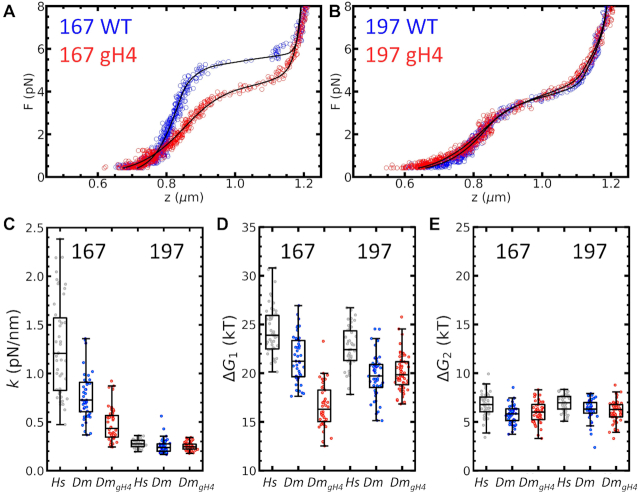
Deletion of the H4 tail affects folding in NRL 167, but not in NRL 197 chromatin fibers. (A) 167 NRL Fibers reconstituted with Dm WT histones (blue dots) unfolded similarly as those with Hs WT histones. Chromatin fibers reconstituted with Dm gH4 mutant histones (red dots) unfolded at a lower force. (B) Surprisingly, deletion of the H4 tail had no observed effect on the mechanical properties of NRL 197 fibers. Fit parameters (black lines) are given in Table S3 of the supplementary material. Irrespective of NRL, Hs WT chromatin fibers had a slightly higher \documentclass[12pt]{minimal}
\usepackage{amsmath}
\usepackage{wasysym}
\usepackage{amsfonts}
\usepackage{amssymb}
\usepackage{amsbsy}
\usepackage{upgreek}
\usepackage{mathrsfs}
\setlength{\oddsidemargin}{-69pt}
\begin{document}
}{}$k$\end{document}, \documentclass[12pt]{minimal}
\usepackage{amsmath}
\usepackage{wasysym}
\usepackage{amsfonts}
\usepackage{amssymb}
\usepackage{amsbsy}
\usepackage{upgreek}
\usepackage{mathrsfs}
\setlength{\oddsidemargin}{-69pt}
\begin{document}
}{}$\Delta {G_1},$\end{document} and \documentclass[12pt]{minimal}
\usepackage{amsmath}
\usepackage{wasysym}
\usepackage{amsfonts}
\usepackage{amssymb}
\usepackage{amsbsy}
\usepackage{upgreek}
\usepackage{mathrsfs}
\setlength{\oddsidemargin}{-69pt}
\begin{document}
}{}$\Delta {G_2}$\end{document} than Dm WT fibers. (C) In NRL 167 fibers, Dm gH4 reduced the fiber stiffness \documentclass[12pt]{minimal}
\usepackage{amsmath}
\usepackage{wasysym}
\usepackage{amsfonts}
\usepackage{amssymb}
\usepackage{amsbsy}
\usepackage{upgreek}
\usepackage{mathrsfs}
\setlength{\oddsidemargin}{-69pt}
\begin{document}
}{}$k$\end{document} significantly compared to WT histones (P < 0.001), while NRL 197 fibers were unaffected (P = 0.98). (D) Unstacking energy \documentclass[12pt]{minimal}
\usepackage{amsmath}
\usepackage{wasysym}
\usepackage{amsfonts}
\usepackage{amssymb}
\usepackage{amsbsy}
\usepackage{upgreek}
\usepackage{mathrsfs}
\setlength{\oddsidemargin}{-69pt}
\begin{document}
}{}$\Delta {G_1}$\end{document} showed the same trend: Hs WT histones featured a slightly higher \documentclass[12pt]{minimal}
\usepackage{amsmath}
\usepackage{wasysym}
\usepackage{amsfonts}
\usepackage{amssymb}
\usepackage{amsbsy}
\usepackage{upgreek}
\usepackage{mathrsfs}
\setlength{\oddsidemargin}{-69pt}
\begin{document}
}{}$\Delta {G_1}$\end{document} than Dm WT histones, both for NRL 167 and NRL 197. Deletion of the H4 tail reduced \documentclass[12pt]{minimal}
\usepackage{amsmath}
\usepackage{wasysym}
\usepackage{amsfonts}
\usepackage{amssymb}
\usepackage{amsbsy}
\usepackage{upgreek}
\usepackage{mathrsfs}
\setlength{\oddsidemargin}{-69pt}
\begin{document}
}{}$\Delta {G_1}$\end{document} for NRL 167 (P < 0.001). For NRL 197 the unstacking energy was not different (P < 0.35). The much lower \documentclass[12pt]{minimal}
\usepackage{amsmath}
\usepackage{wasysym}
\usepackage{amsfonts}
\usepackage{amssymb}
\usepackage{amsbsy}
\usepackage{upgreek}
\usepackage{mathrsfs}
\setlength{\oddsidemargin}{-69pt}
\begin{document}
}{}$\Delta {G_1}$\end{document} for Dm gH4 chromatin with NRL 167 suggests an absence of higher-order structure. (E) As expected, the partial unwrapping energy \documentclass[12pt]{minimal}
\usepackage{amsmath}
\usepackage{wasysym}
\usepackage{amsfonts}
\usepackage{amssymb}
\usepackage{amsbsy}
\usepackage{upgreek}
\usepackage{mathrsfs}
\setlength{\oddsidemargin}{-69pt}
\begin{document}
}{}$\Delta {G_2}$\end{document} remained constant irrespective of NRL or the presence of the H4 tail (P = 0.43 for NRL 167, P = 0.41 for NRL 197). The number of experiments per fiber type was 47 ± 6 (mean ± std). The average and standard deviations of the fitted parameters are given in Table S4 of the supplementary material.